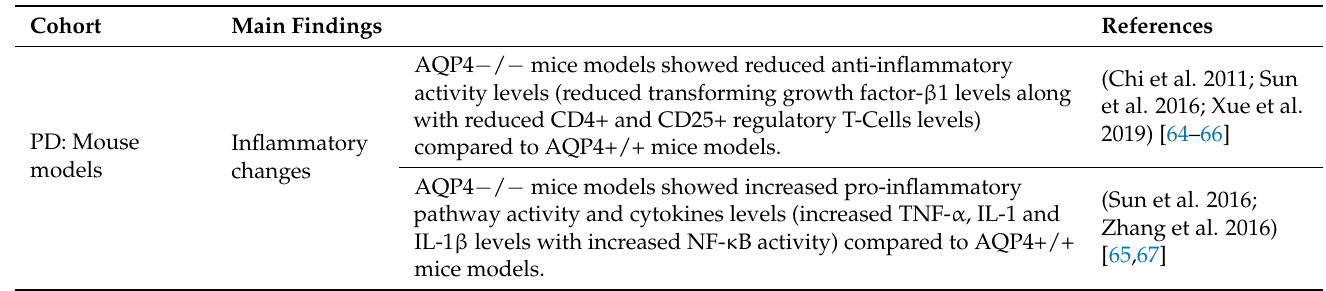
Table 2. Summary of the main findings from studies exploring glymphatic changes in Parkinson’s Disease. Cohort Main